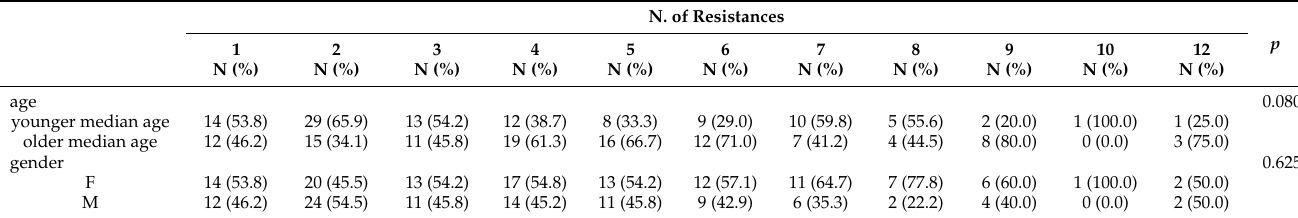
Table 7. Distribution of microbial resistance stratified for age of the patients (younger vs. older median age) and gender. N. of Resistances